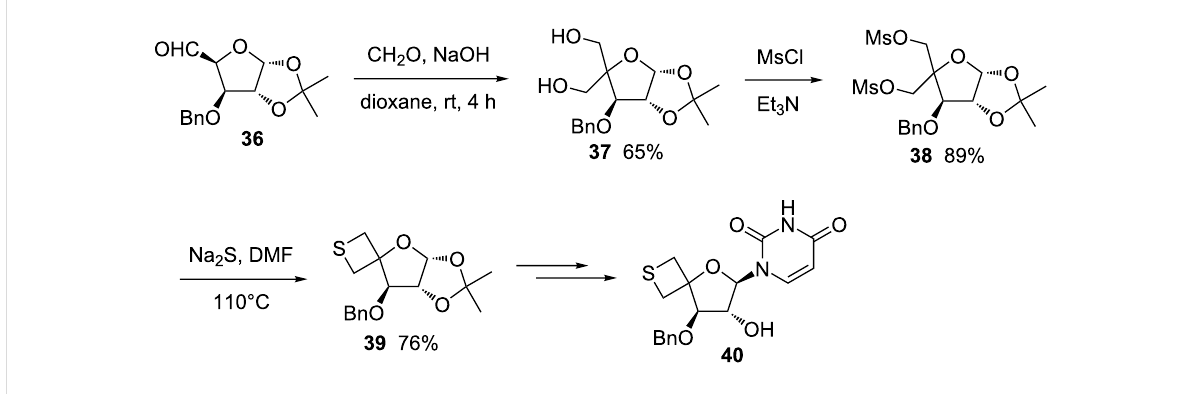
Scheme 8: Synthesis of thietane-containing spironucleoside 40 from 5-aldo-3- O -benzyl-1,2- O -isopropylidene- α -D-glucofuranose ( 36 ).